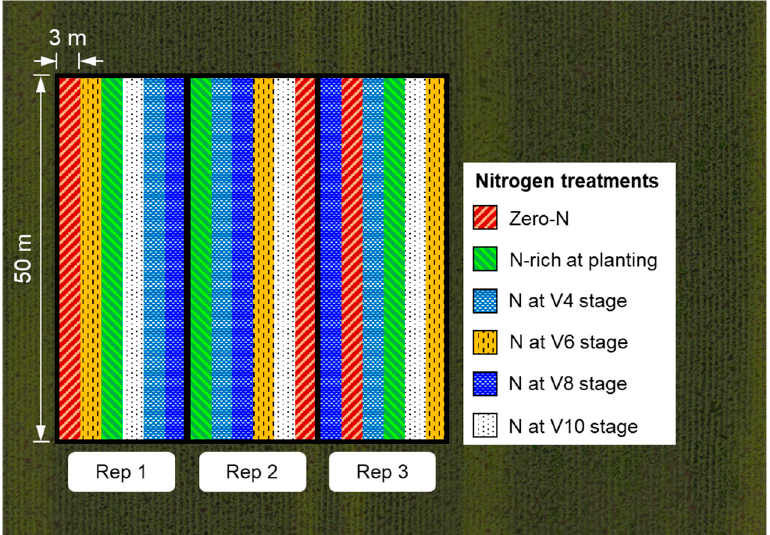
Figure 2. Illustration of the experimental design and UAS data collection timing for N treatments conducted at the Musgrave Research Farm, Aurora, NY, USA. The base-map shown is the aerial imagery obtained at the R4 growth stage of corn on August 22, 2019. The zero-N treatment received starter N (33 kg N ha − 1 ) only, the N-rich treatment received 336 kg N ha − 1 before emergence, and all four sidedress treatments received 202 kg N ha − 1 at their respective growth stages.